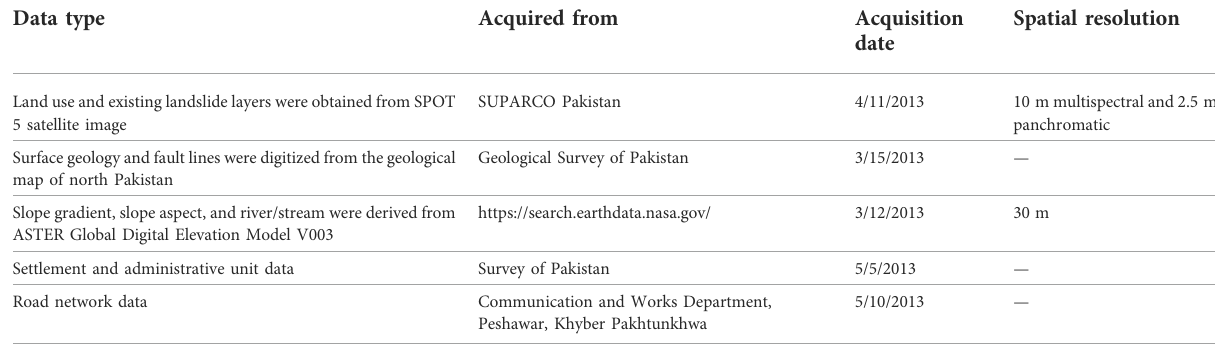
TABLE 1 Dataset used in the study and source of